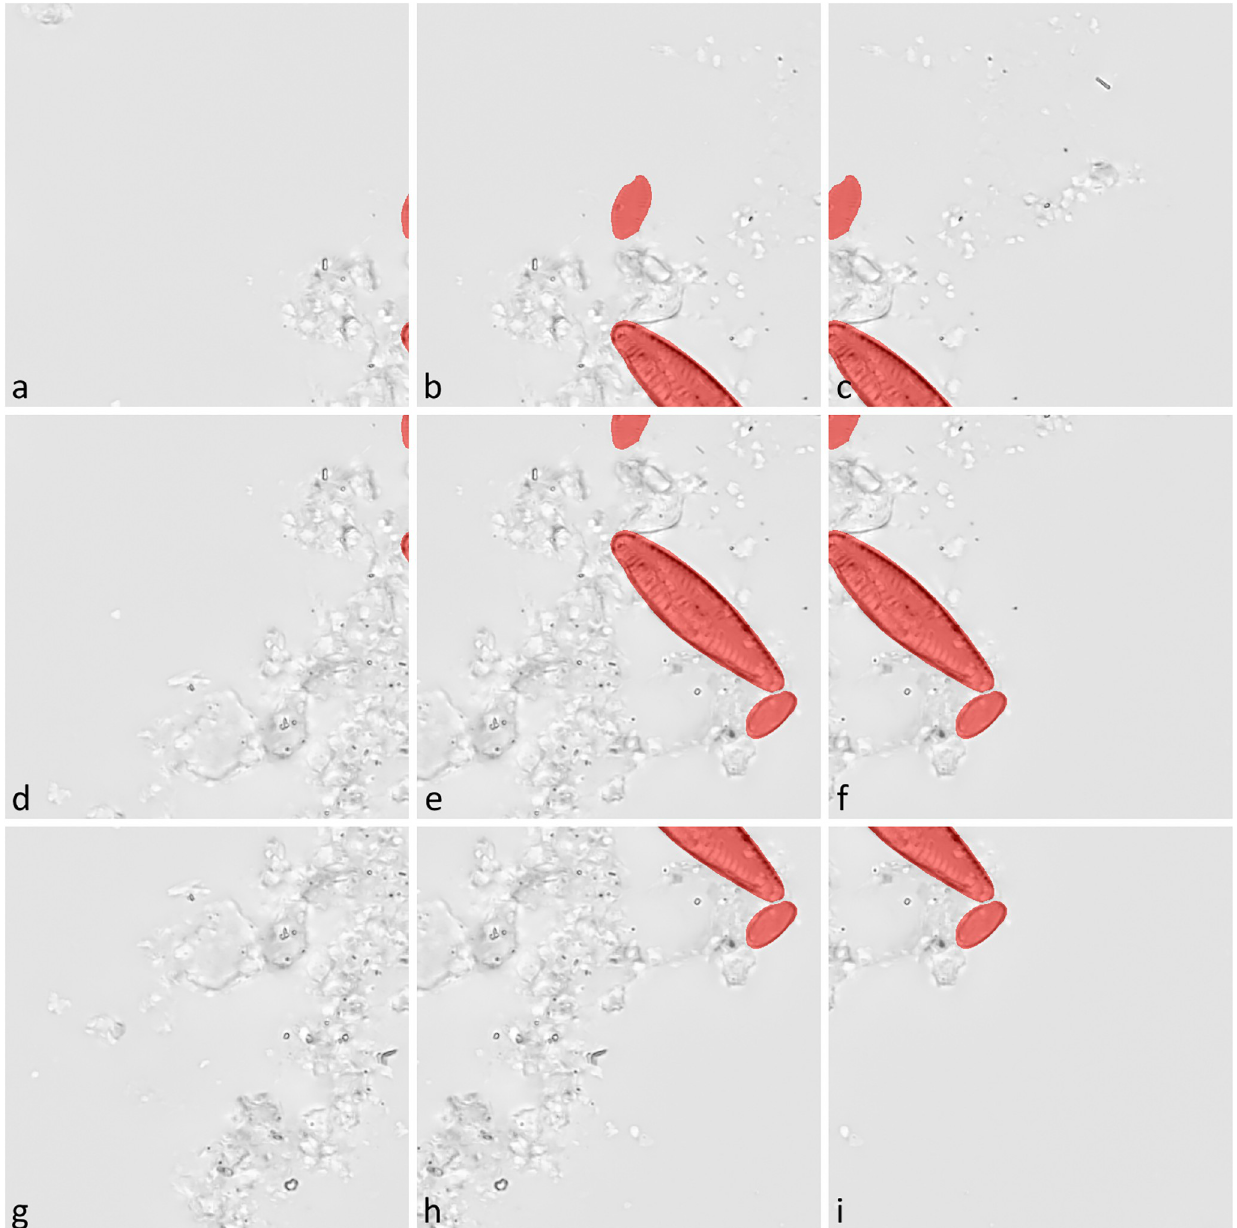
Fig 4. Example of tiles generated by the fixed-stride tiling method. Red highlights mark areas which were used to define the segmentation mask (ground truth); objects might be truncated arbitrarily by the tile margins (a-f, h, i). Tiles not containing any diatom object were excluded from the training data (g). https://doi.org/10.1371/journal.pone.0272103.g004 2. Object-based positioning: Tiles were positioned with respect to the boundaries of the man- ually annotated, SHERPA-refined outline of each relevant diatom object. In each tile the object was justified horizontally either to the left, center, right and vertically either to the top, center, bottom, respectively, factoring in a margin of 10 pixel between the object and the tile boundaries. As a result, each object was depicted at least partially in the nine different tiles based on its position (Fig 5, colored highlights), but might also be (partially)